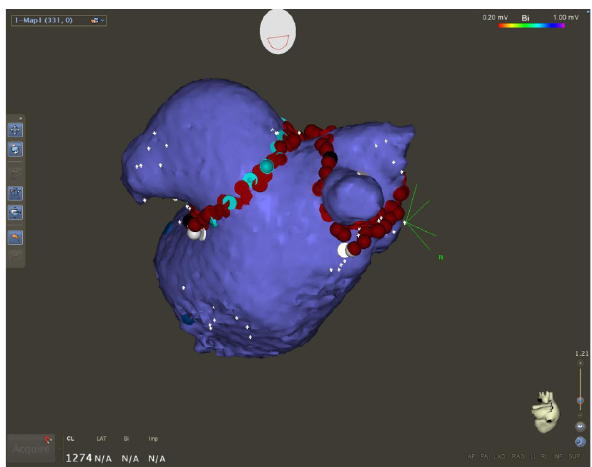
Fig. 3. CARTO3 CT map of the left atrium: red spots denote points of application of radiofrequency energy, white spots de- note anchors of the electro-anatomic map (anatomical land- marks defined by intra-cardial ultrasound), pale blue spots denote points planned for ablation, dark blue spots denote mi- tral anulus, black spot denotes point of isolation of pulmonary